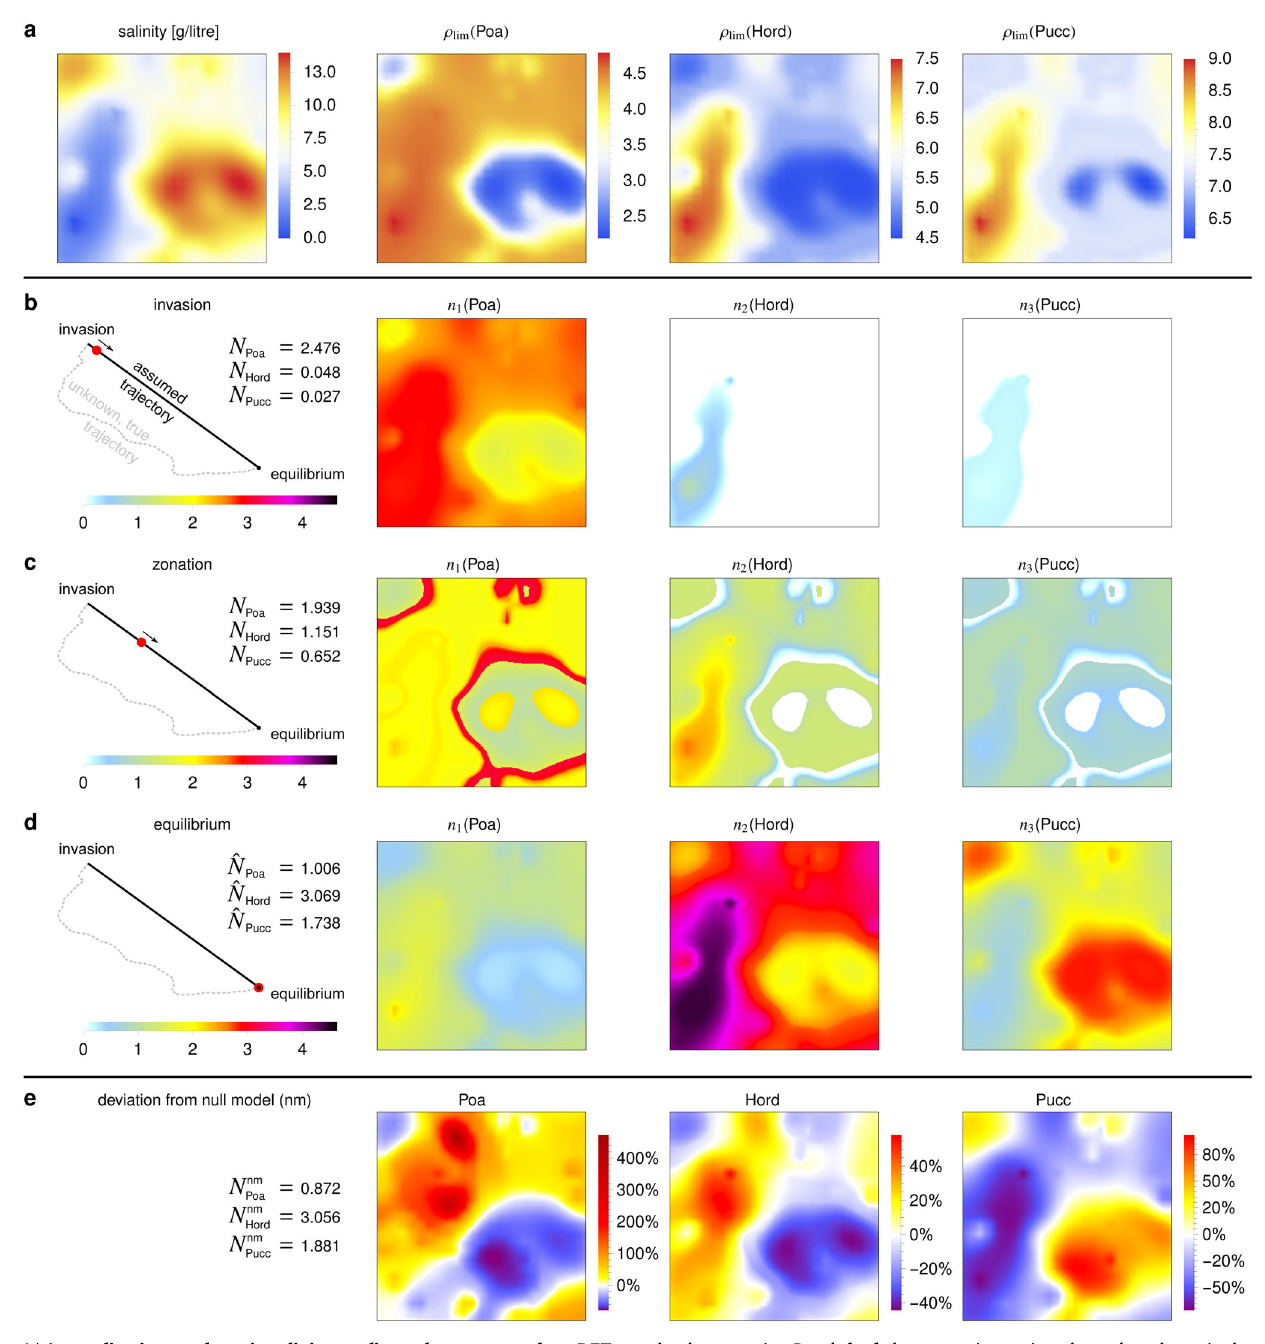
the three species. Panels b – d also approximate time-dependent dynamics by showing snapshots of density distributions along the linear trajectory in the space of abundances from an initial state where Poa is in monoculture ( N =(2.499,0.0,0.0) (see Supplementary Fig. 4a) to the global equilibrium at N = ^ N = ð 1 : 006,3 : 069,1 : 738 Þ ,asindicatedbythereddotsinthesketches.Themodel predicts a rich zoo of phases (see Methods and Supplementary Fig. 4), including zonationasatransient state ( c ) onthe waytothesmooth equilibratedmixture( d ). The large relative deviations of DFTe densities from those of a generic envelope model ( N nm =(0.872,3.056,1.881)), which in this case represents a null model, reveal the substantial impact of heterogeneity on the grass distributions ( e